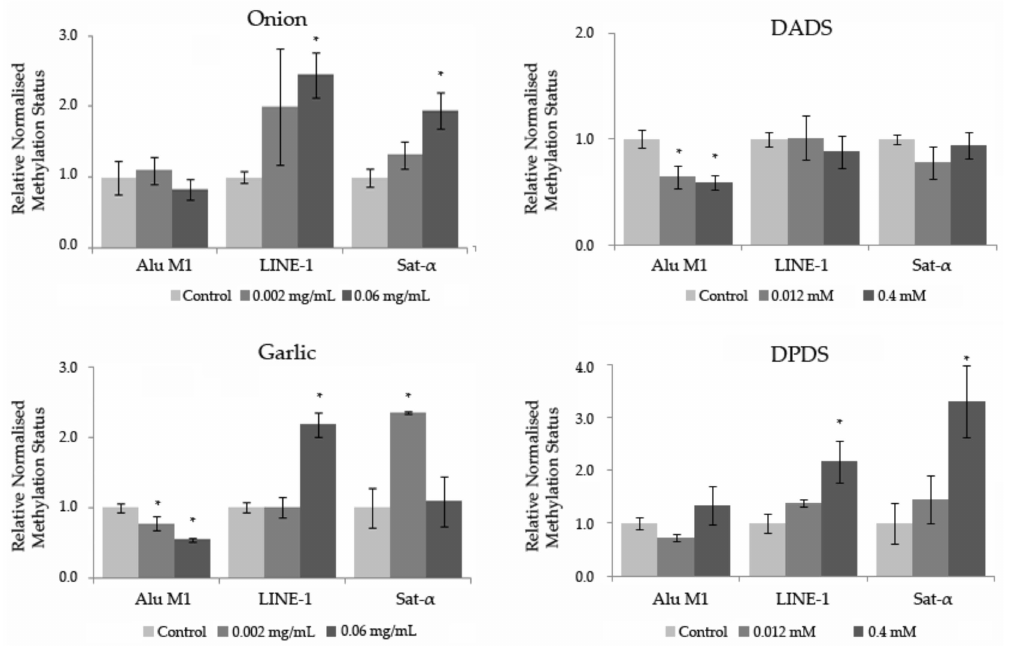
Figure 6. Methylation status of Allium sp. vegetables, DADS, and DPDS in HL-60 cells. Relative normalized expression data of each repetitive element (Alu M1, LINE-1, and Sat- α ). Values represent the mean ± SE from three independent experiments. * p ≤